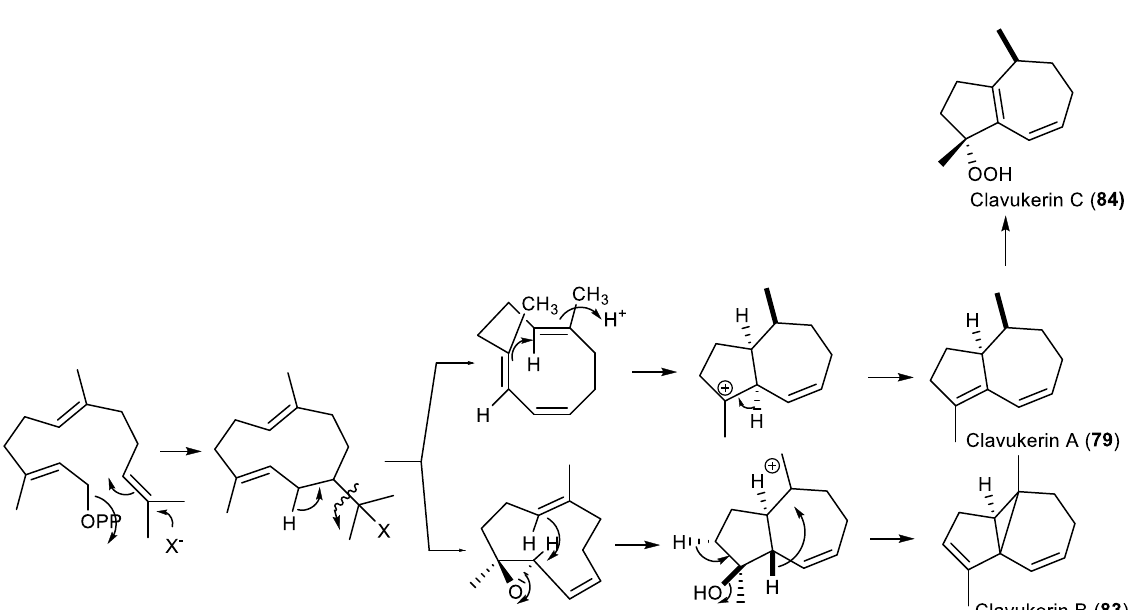
Figure 17. Incorporation of 13 C from [2- 13 C]-labeled acetate into compounds 94 , 95 and 106 (adapted from Takeda and Katoh 1983b [272]).